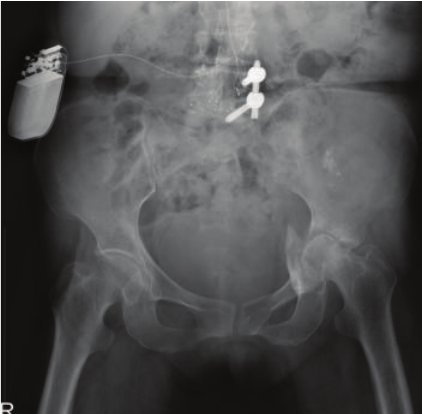
Figure 2: Radiograph taken 4 months after seizure episode showing left hip joint-space narrowing with femoral head